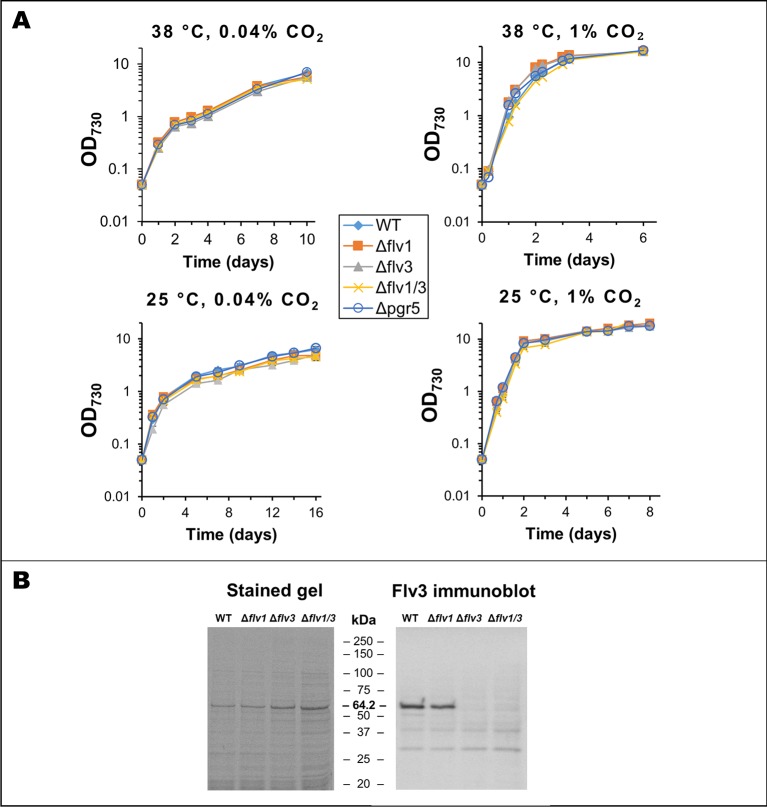
Analysis of flv and pgr5 knock-out strains. (A) Growth curves for WT, Δflv1, Δflv3, Δflv1/Δflv3, and Δpgr5 strains in different conditions. Data is an average of 3 biological replicates, measured in technical duplicates. In all cases, the total light intensity was 250 µmol photons·m-2·s-1. (B) Analysis of Flv3 expression in different strains. Left panel: Coomassie stained SDS-PAGE gel of whole cell lysates from WT and different flv deletion strains. Right panel: Immunoblot using same samples, developed using a specific anti-Flv3 antibody (a kind gift from Toshiharu Shikanai). All lanes loaded with 15 µg total protein. Numbers on the left of each image represent the migration of respective molecular weight markers.